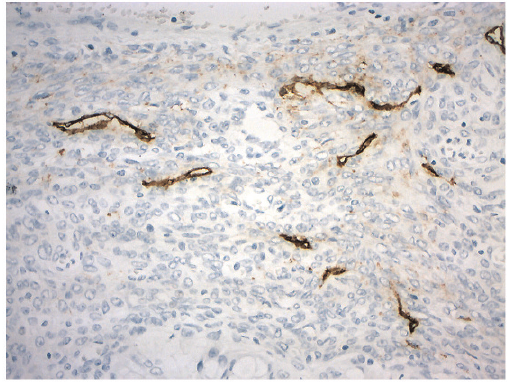
Figure 3 - Mucinous ovarian tumor showing ten lymphatic vessels identified by podoplanin staining using the D2-40 antibody (original magnification